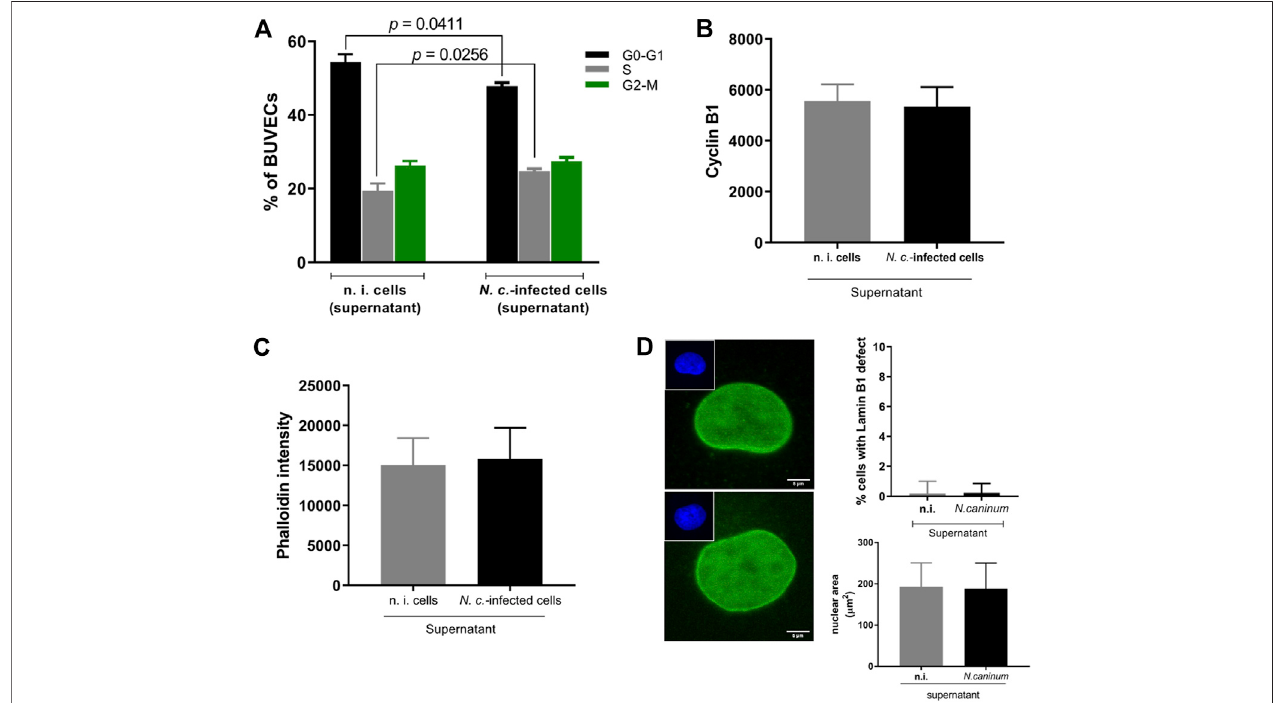
FIGURE 8| Analysis of N. caninum infection-derived supernatant paracrineeffectson host cell cycle progression and the nuclear shape ofnon-infected host cells. SixbiologicalBUVEC( n= 6)replicateswereinfectedwith N.caninum tachyzoitesand,after32 hp.i.,themedium(i.e.,supernatant)wasisolatedand fi lteredtoeraseany contaminationwithtachyzoites/celldebris.Thenon-infectedand N.caninum- infectedhostcellsupernatantwasimmediatelytransferredtonon-infectedmonolayersand incubated for 32 h in order to analyze paracrine effects on host cell cycle progression and nuclear shape. (A) BUVEC populations were fi rst gated, and the histogramsforpropidiumiodide(PI)wereconductedinordertodifferentiatethemeanpeaksofthehistograms.Datawereplottedasthepercentageoftotalcellsvs.DNA amounts found in each G0/G1-, S- and G2/M-phase. (B, C) Analyses of cyclin B1 and F-actin by FACS-based quanti fi cation. (D) Lamin B1 detection by immuno fl uorescence(green)andthenuclearareabyDAPI(leftinset)staining.Thenuclearsizewasquanti fi edusingtheDAPIchannelandrepresentedinthegraph.Bars represent the median ±SD of six biological replicates. The scale bar represents 5